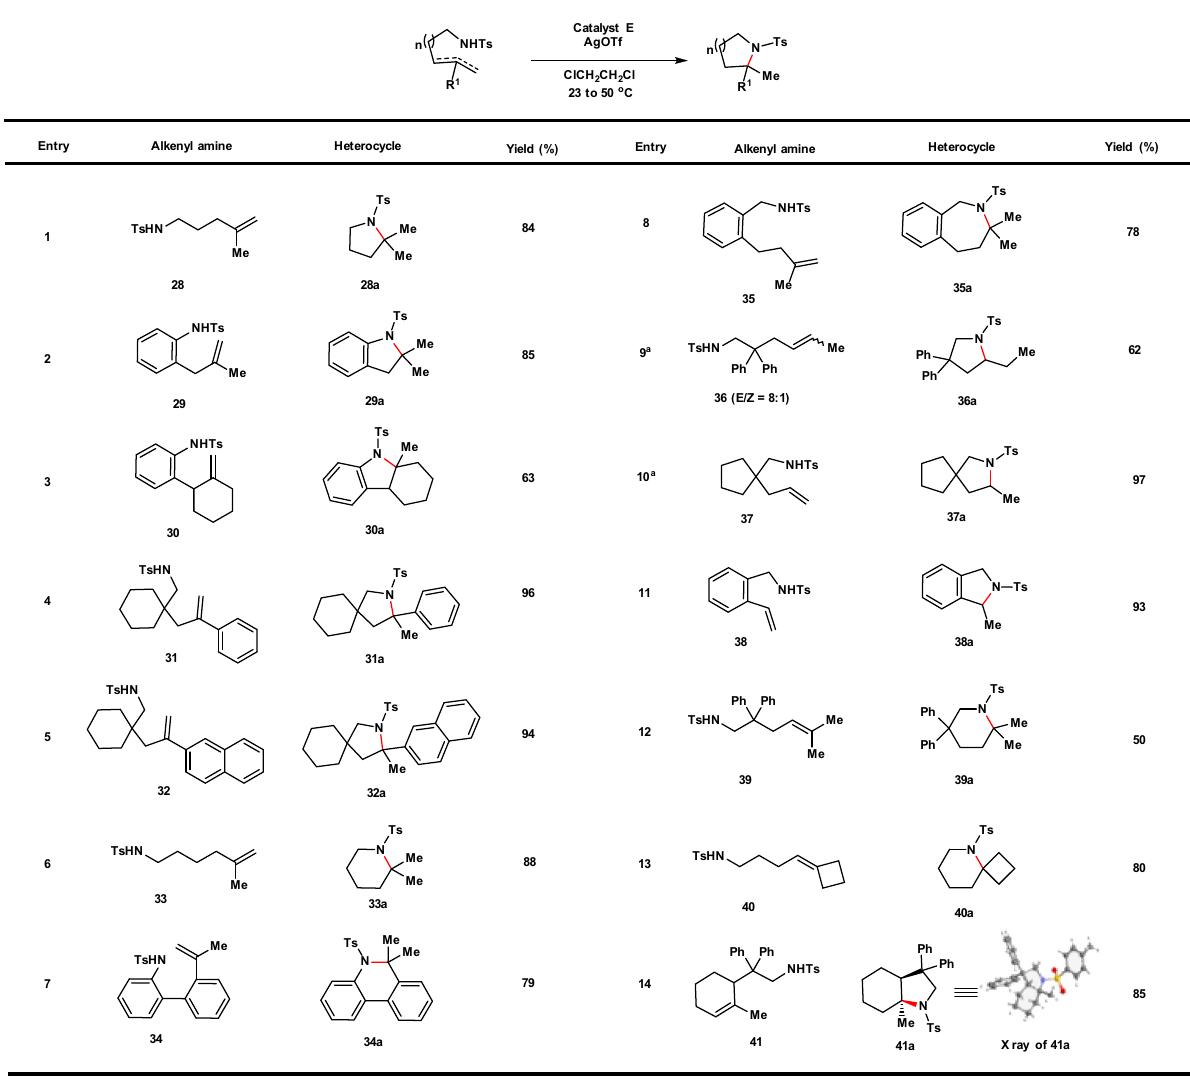
Fig. 5 Substrate scope for intramolecular hydroamination. General conditions: catalyst E (1 mol%), AgOTf (2 mol%), 23 °C, 24 h. Yields of isolated products were given. a Catalyst E (5 mol%), AgOTf (6 mol%), 50 °C, 48